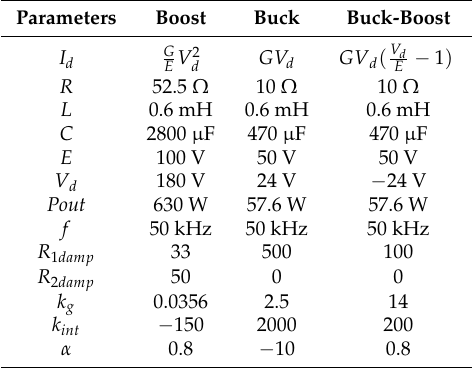
Table 5. Initial and converters